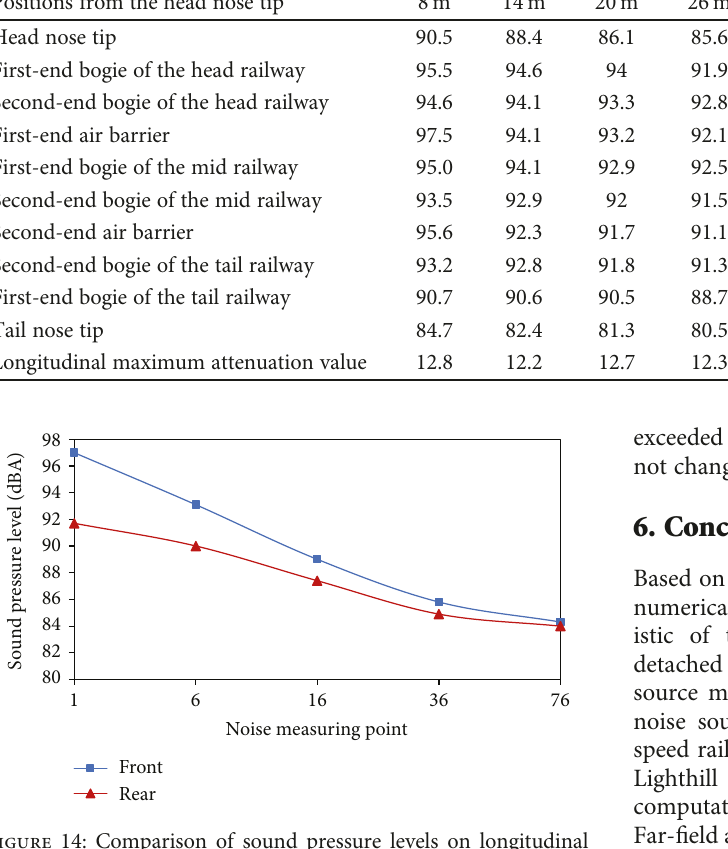
Figure 14: Comparison of sound pressure levels on longitudinal monitoring